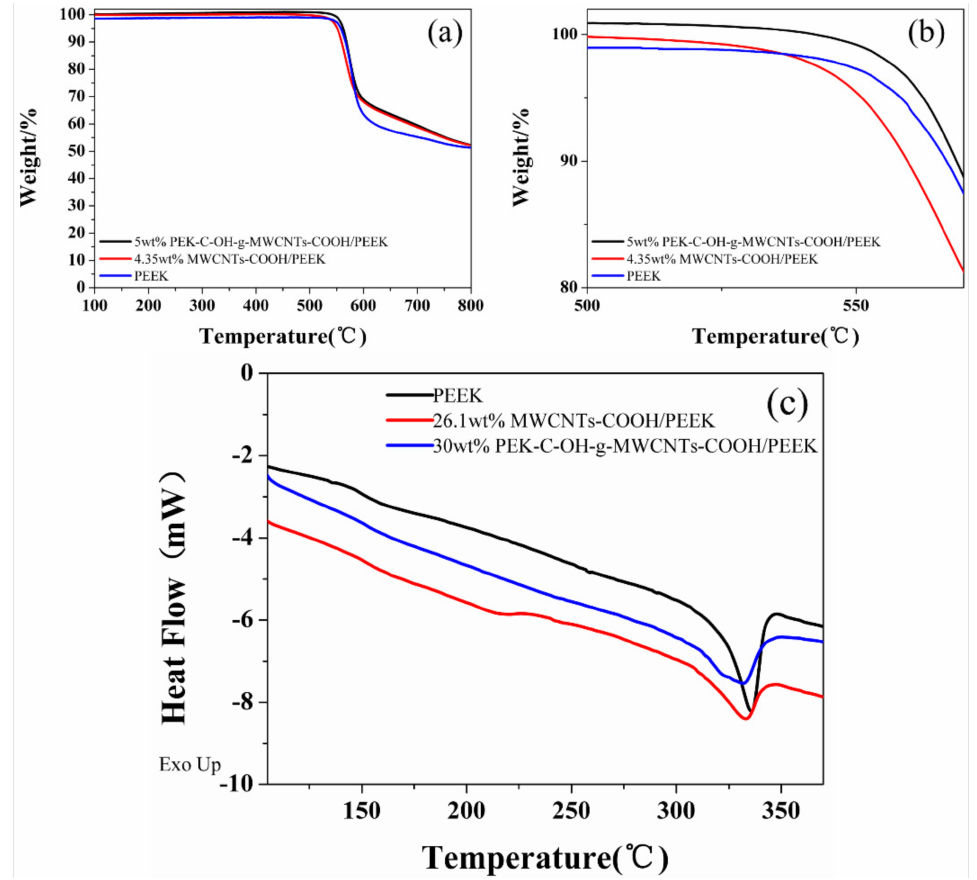
Figure 8. ( a , b ) TGA curvs of MWCNTs/PEEK composites; ( c ) DSC curvs of MWCNTs/PEEK